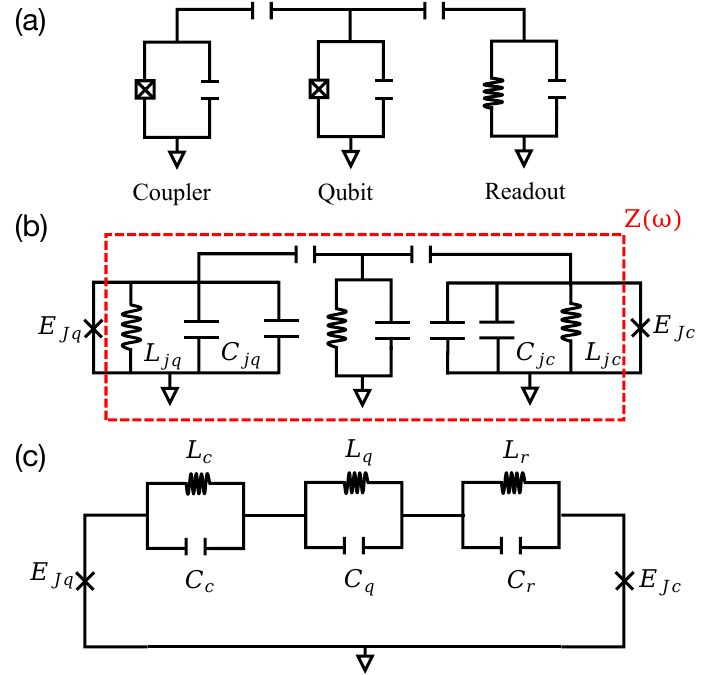
Figure 1. ( a ) Simplified system diagram of the frequency-tunable coupler. ( b ) All capacitors and inductors in the circuit form an impedance network Z ( ω ) . ( c ) The impedance network Z ( ω ) is decomposed into three series LC circuits by the Foster theorem and the two-port network